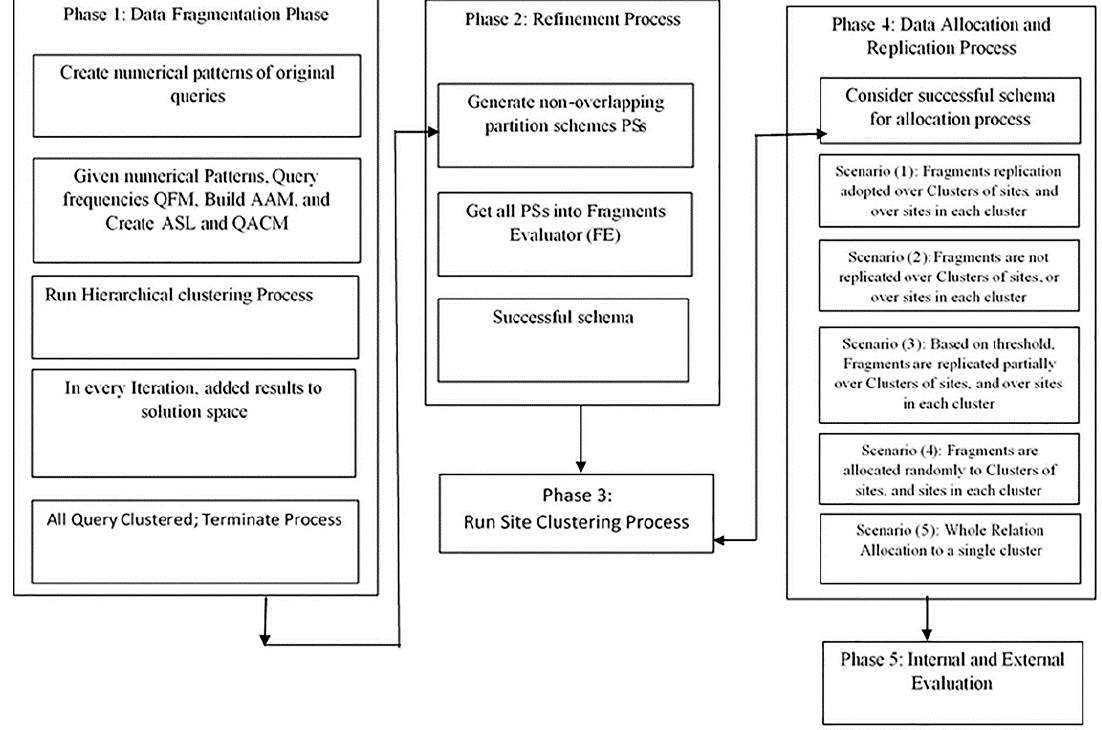
Figure 1. Overview of vertical fragmentation and allocation heuristics.